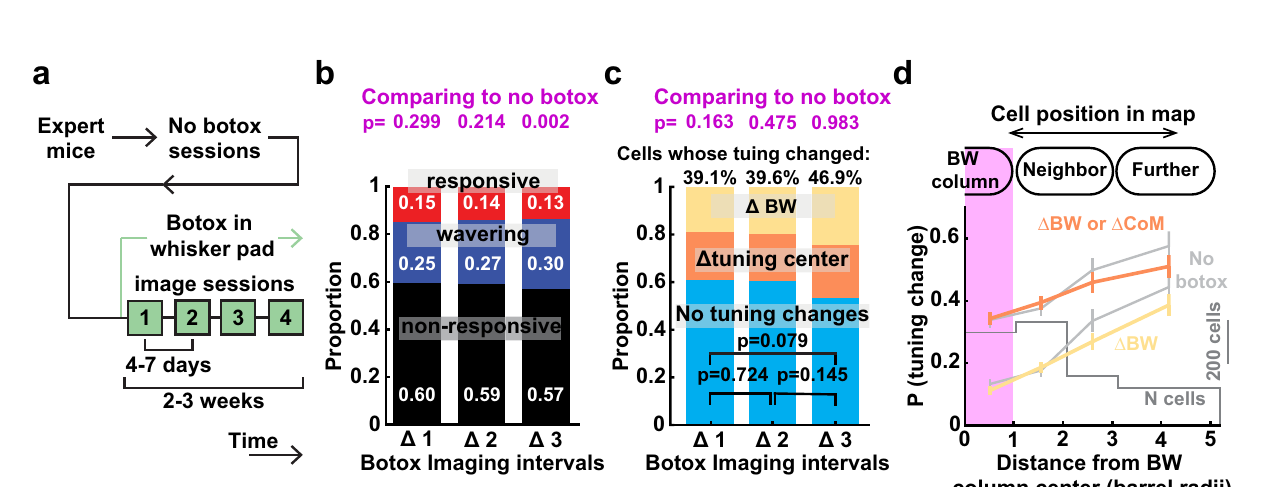
Fig. 6 | Tuning instability is structured within the L2/3 whisker map. a Spatial organization of tuning instability. Left: mean fraction of neurons exhibiting a CoM change or a BW change, as a function of cell distance to its BW column center in session 1. Cells in the magenta area were initially CW-tuned. Right: Spatial dis- tribution of cells (based on Session 1) in each tuning stability group. Data pooled across Δ 1, Δ 2, and Δ 3 intervals (1270 pairs). Same dataset also in ( c – e ). b Tuning dynamicsover Δ 1session(4 – 7dayinterval),forallneuronsfrom4imaging fi eldsin oneexamplemouse.CirclesshowcelllocationrelativetotheBWcolumninSession 1. Black circle: BW column boundary. Gray dash: Surrounding columns. Arrows show Δ CoM for each cell with a signi fi cant BW or CoM change. c Probability of tuning change as a function of initial BW response magnitude. Dashed line: linear regression. Statistics: two-sided t-statistic for slope ≠ zero. d Probability of tuning changeasafunctionofinitialtuningsharpness.Conventionsasin( c ). e Probability